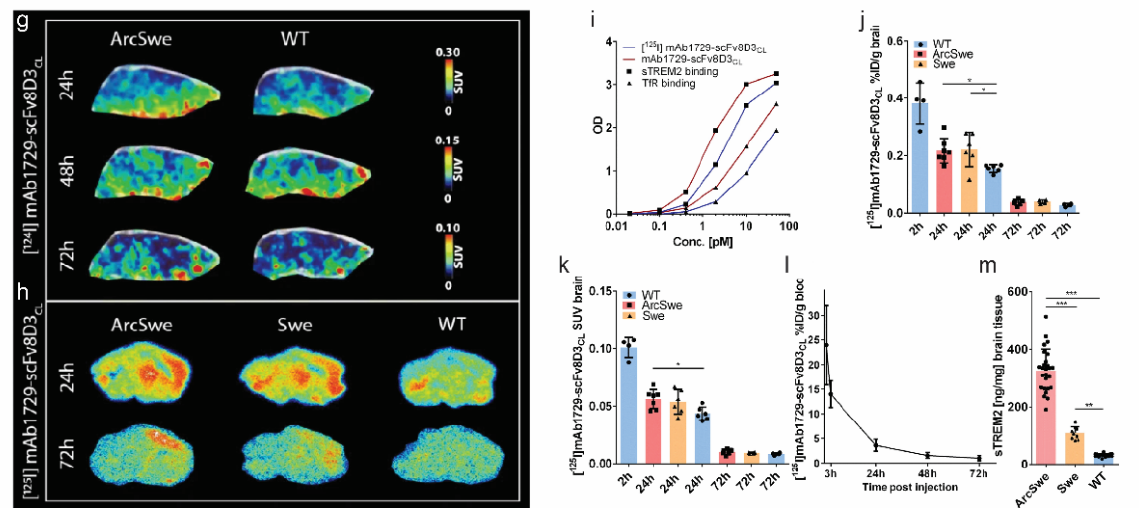
Figure 3. In vivo imaging of blood–brain barrier, astrocytosis, and triggering receptors expressed on myeloid cells (TREM) 2 in amyloidosis animal models of Alzheimer’s disease: ( a – d ) imaging of P-glycoprotein (P-gp, ABCB1) using ( R )-[ 11 C]verapamil; ( a ) sagittal PET summation images (0–60 min) of wild-type and APP/PS1 mice aged 50, 200 and 380 days and Abcb1a/b (+/−) mice pre-treated i.v . with vehicle ( b ) or tariquidar (4 mg/kg) ( c ) at 2 h before start of the PET scan. The whole-brain region is highlighted as a white line. In ( d ), the mean percentage increase in Kp, brain of individual tariquidar-treated animals relative to mean Kp, brain value of vehicle group is shown. Ns: not significant, * p < 0.05, *** p < 0.001. Reproduced from [133] from Sage Publication; ( e , f ) [ 11 C]deuterium-l-deprenyl ([ 11 C]DED) microPET imaging in APPswe and wild-type (WT) mice: ( e ) [ 11 C]DED microPET coronal parametric BP ND maps images; (f) [ 11 C]DED binding in the cortex and hippocampus, expressed as BP ND , obtained from simplified reference tissue model of [ 11 C]DED using the cerebellum as a reference region, in three groups of APPswe mice aged 6-, 8–15, and 18–24 months and two groups of wild-type mice aged 8–15 and 18–24 months. Significant differences between groups are indicated by * p < 0.05. Reproduced from [82] with permission from Springer Nature; ( g – m ) PET imaging of triggering receptor expressed on myeloid cells 2 (TREM2) level in ArcSwe, Swe, and wild-type mice; ( g ) representative SUV scaled sagittal PET images with [ 124 I]mAb1729-scFv8D3CL at 24 h, 48 h, and 72 h after injection; ( h ) radioligand distribution in brain tissue displayed in sagittal ex vivo autoradiography images in ArcSwe, Swe, and wild-type animals at 24 h and 72 h after injection ( h ); ( i ) binding comparison of [ 125 I]mAb1729-scFv8D3CL and unlabelled mAb1729-scFv8D3CL by using ELISA. Percent of injected dose ( j ) and SUV ( k ) of [ 125 I]mAb1729-scFv8D3CL in brain 2 h, 24 h, and 72 h after injection; ( l ) level of [ 124 I]mAb1729-scFv8D3CL in blood, which was sampled 1 h, 3 h, 24 h, 48 h, and 72 h after injection; ( m ) TREM2 levels in TBS extracted brains of ArcSwe, APPSwe, and wild-type mice at the age of 18 months. Reproduced from [205] with permission from Springer